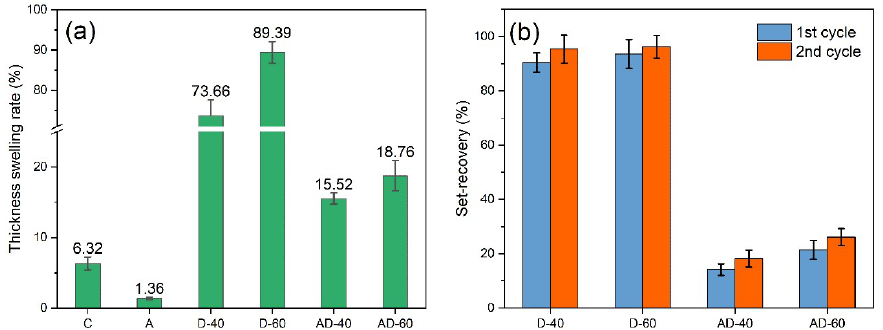
Figure 2. Thickness swelling rate ( a ) and set recovery ( b ) of densified wood samples after 24-h water immersion.